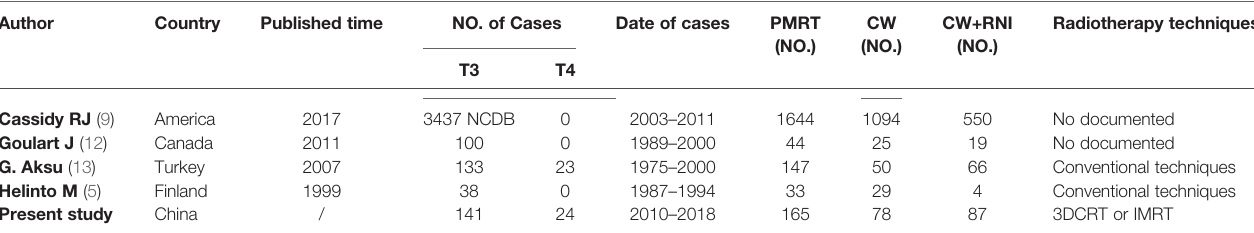
TABLE 5 | Characteristics on radiotherapy to chest wall with or without regional lymph node in previous three reports and the present